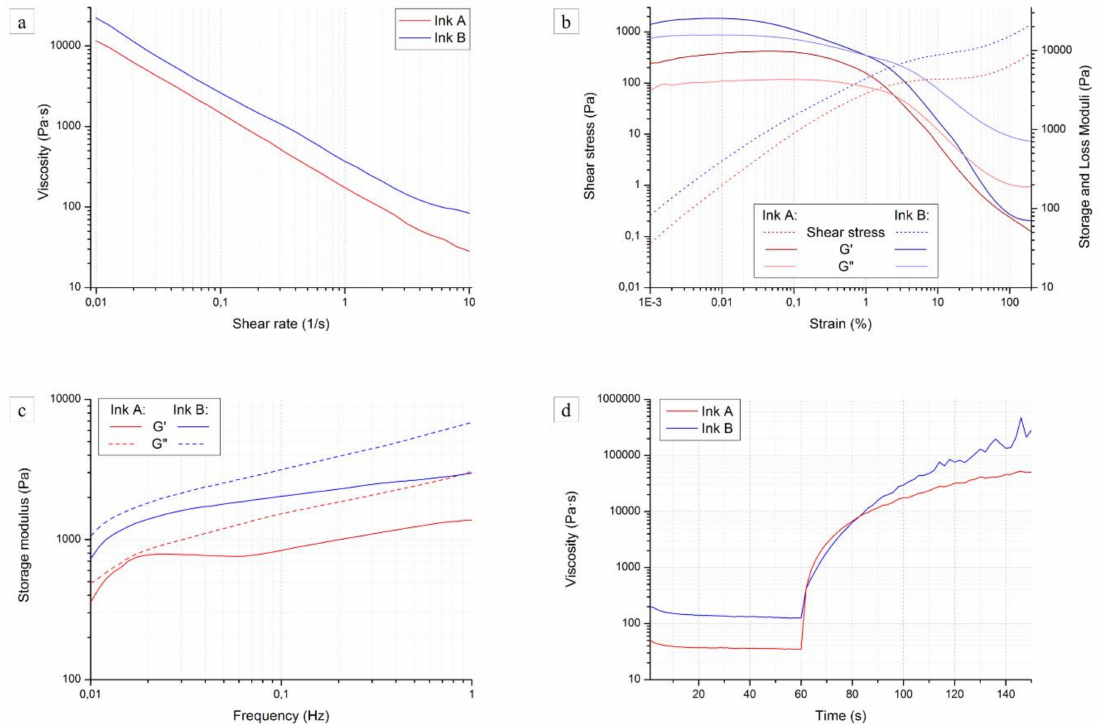
Figure 4. Rheological characterization of Ink A and Ink B: ( a ) viscosity η (Pa · s) against shear rate γ (cid:48) (1/s); ( b ) storage modulus G (cid:48) (Pa), loss modulus G (cid:48)(cid:48) (Pa), and shear stress τ (Pa) against strain γ (%); ( c ) G (cid:48) (Pa) and G (cid:48)(cid:48) (Pa) against frequency; ( d ) η (Pa · s) against time t